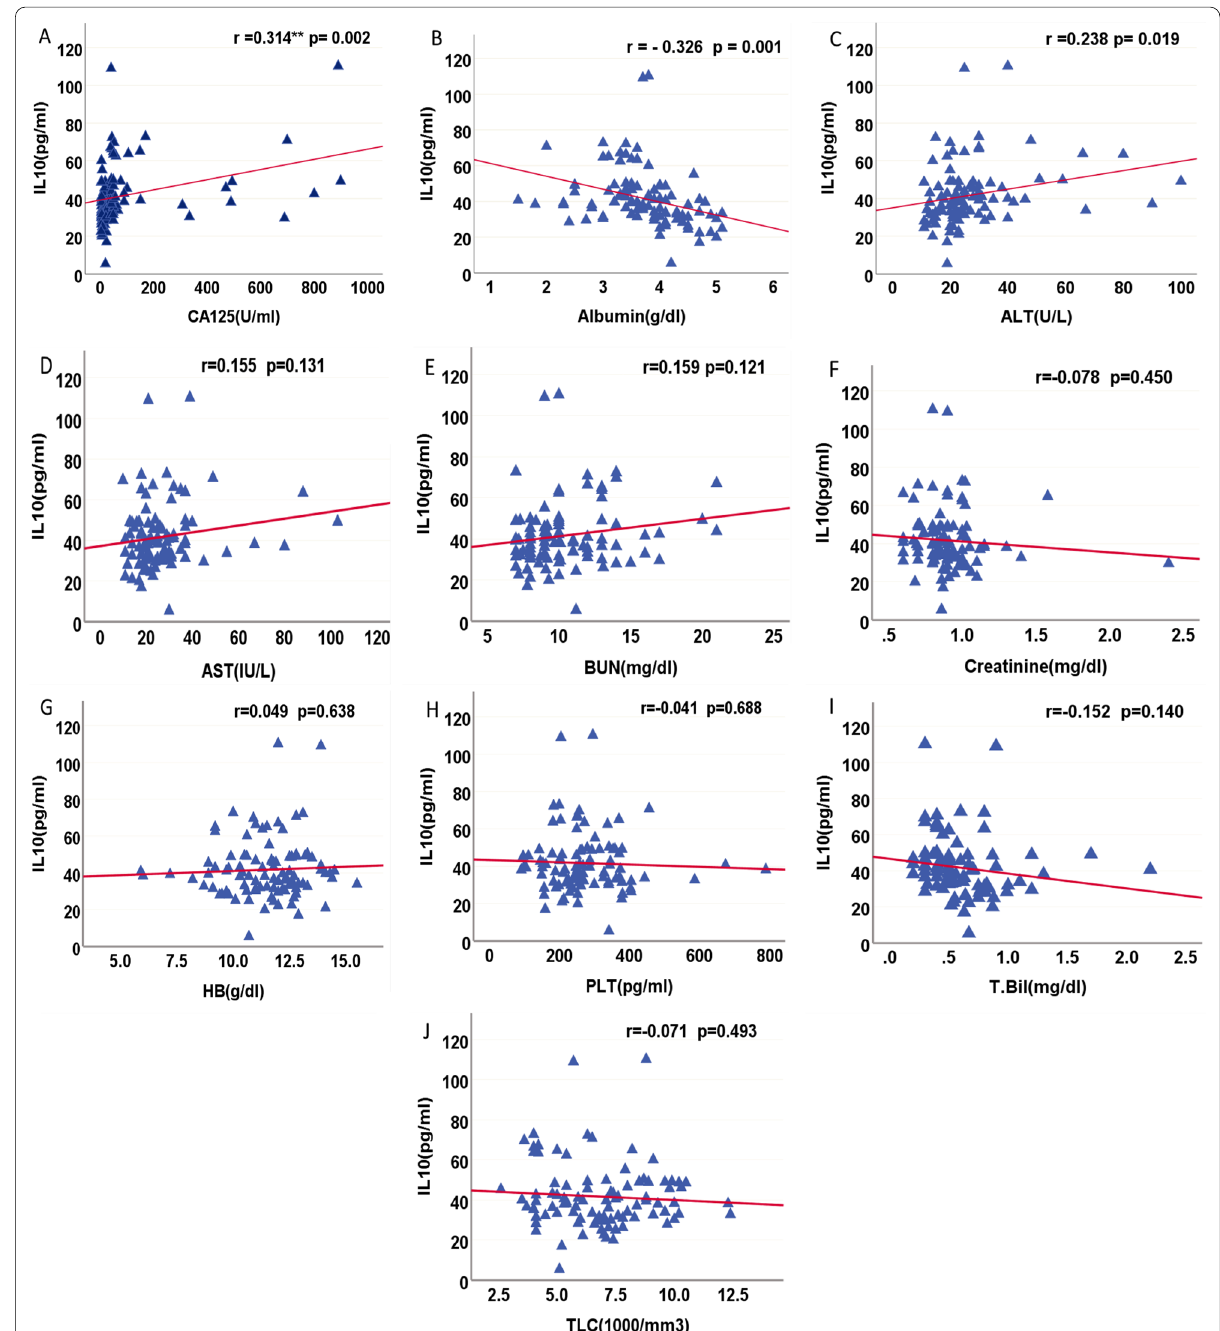
Fig. 5 Correlation between IL10 (pg/ml) with A CA125, B albumin, C ALT, D AST, E BUN, F creatinine, G HB, H PLT, I T. Bil, and J TLC among OC and control groups, Pearson’s correlation coefficient. * P < 0.05, ** P < 0.01, and *** P < 0.001. Abbreviations: IL, interleukin; AST, aspartate aminotransferase; ALT, alanine aminotransferase; BUN, blood urea nitrogen; CA125, cancer antigen 125; and TLC, total leucocytic